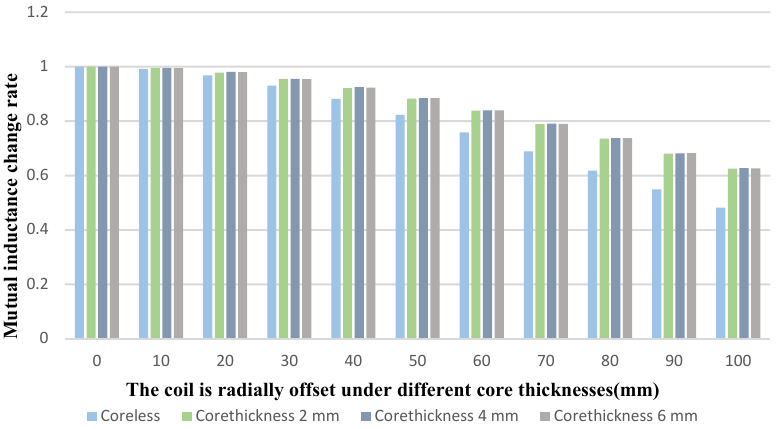
Figure 11. Variation curve of mutual inductance during offset under different core thicknesses.